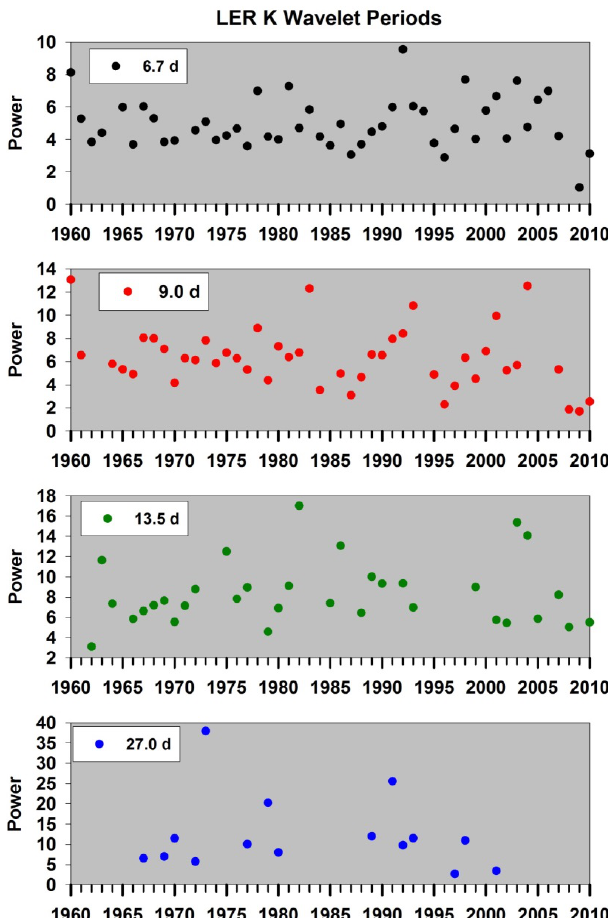
Figure 2. Recurrence periods as identified by wavelet analysis of LER annual time series K indices from 1960 until